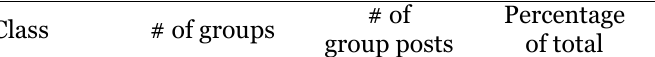
Descriptive Statistics of the Number of Posts per